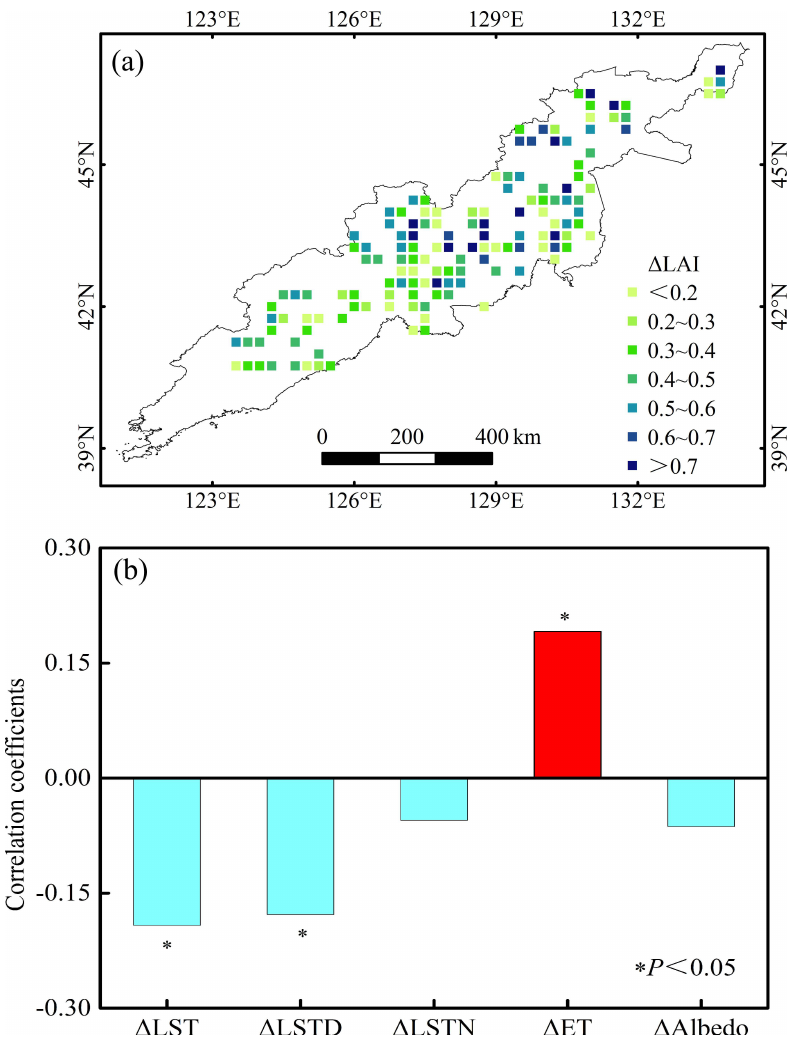
Figure 7. Spatial distribution of differences in leaf area index ( ∆ LAI ) ( a ) and correlation coefficients ( b ) between differences in leaf area index ( ∆ LAI ) and differences in summer average surface tempera- ture ( ∆ LST), daytime surface temperature ( ∆ LSTD), and nighttime surface temperature ( ∆ LSTN), evapotranspiration ( ∆ ET), and albedo ( ∆ Albedo) between high- and low-coverage forest in Changbai Mountain from 2003 to